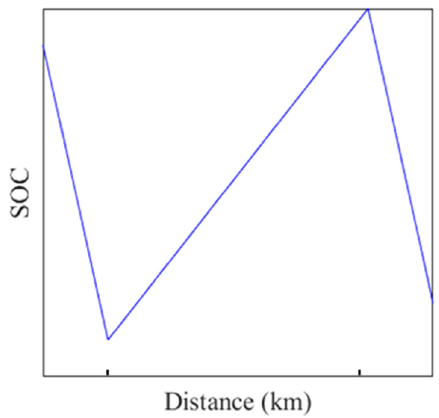
Figure 7. SOC reference